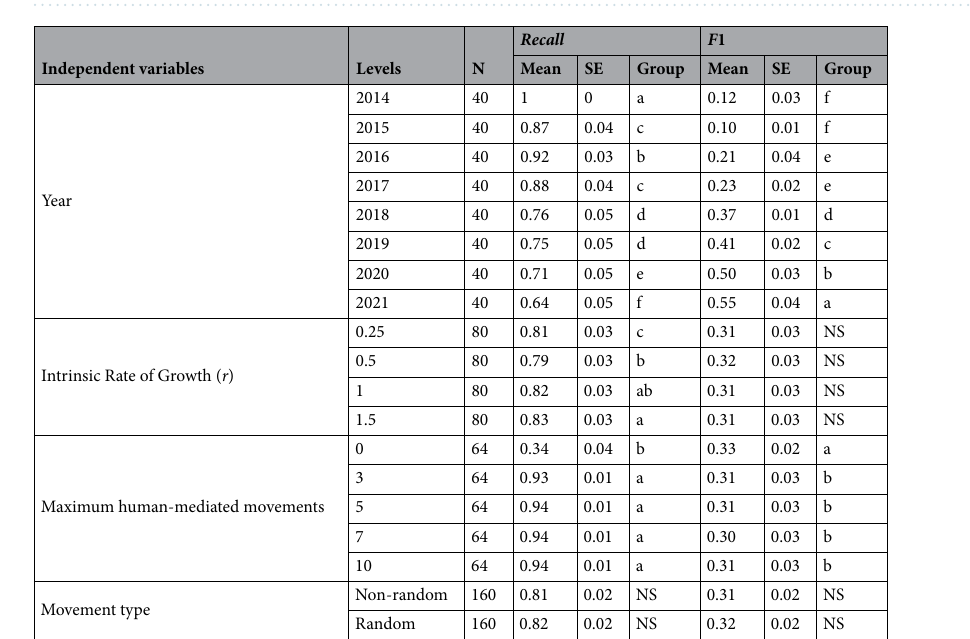
Figure 6. Comparison of Recall ( A – D ) and F 1 ( E – H ) model performance metrics (range between 0 and 1, where 1 is highest model performance) among model simulation scenarios between 2014 and 2021. Scenarios included varying intrinsic growth rates ( r ) from 0.25 to 1.5, and both non-random (solid lines) and random (dashed lines) individual movement types. Colored points and lines indicate the modeled influence of the maximum number of human-mediated movements per year.